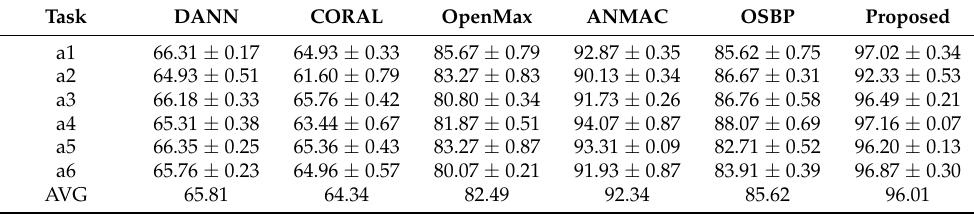
Table 4. Diagnostic results in the lab gearbox dataset (accuracy (%) ± standard